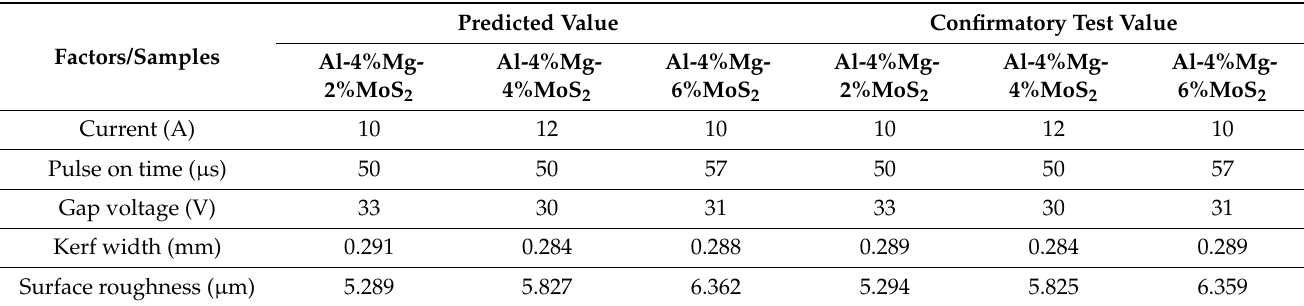
Table 5. Comparison of Predicted and Confirmatory test